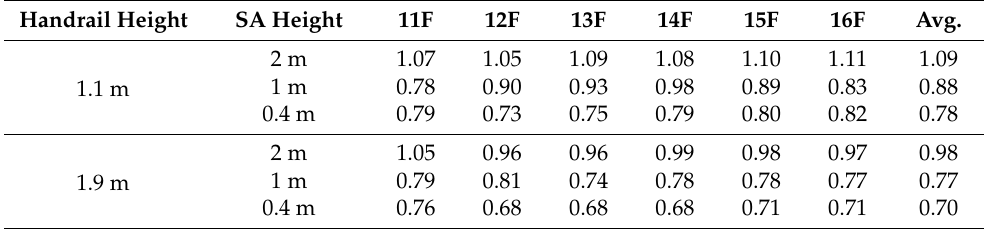
Table 10. PMV values with various handrail and SA heights. Handrail